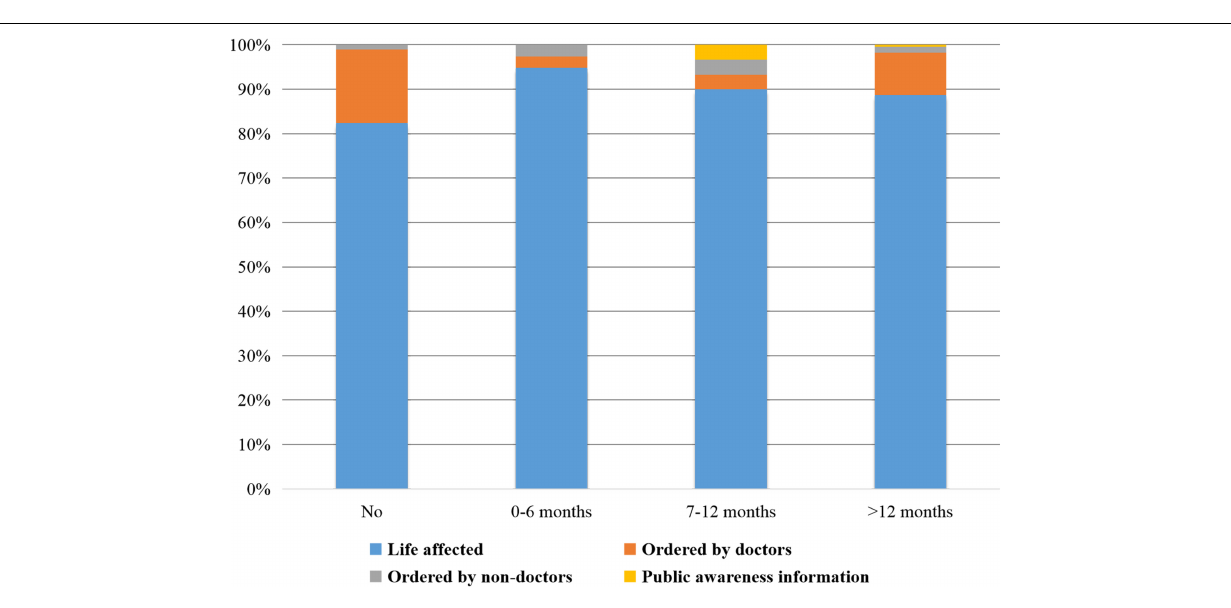
FIGURE 2 | Distribution of durations of delaying surgery and reasons for finally undergoing surgery. The reasons why patients finally accepted surgery indicated no distributional differences among the four groups ( P = 0.066). Notably, 351 (87.75%) patients chose to undergo surgery because their lives were affected and 41 (10.25%) patients chose to undergo surgery as recommended by